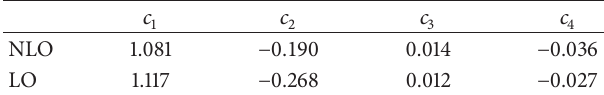
Table 1: Wilson coefficients 𝑐 𝑖 in the NDR scheme at the leading order and next to leading order.